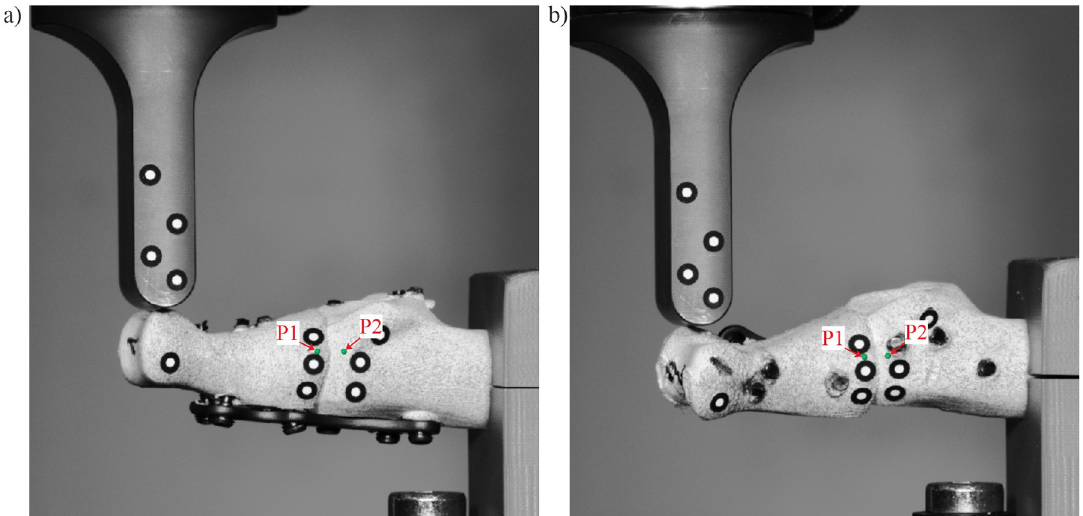
Fig 3. Lateral view from the DIC camera: a) specimen #1; b) specimen